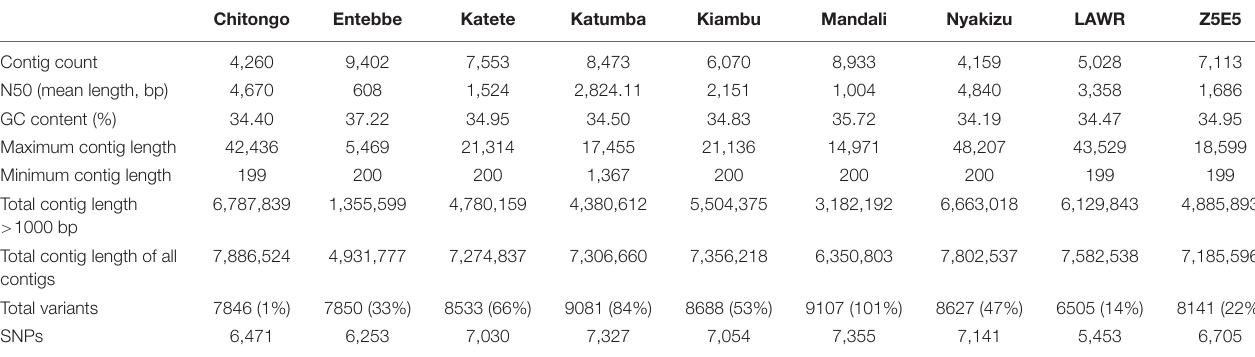
TABLE 5 | Genome features of eastern and southern African T. parva strains.